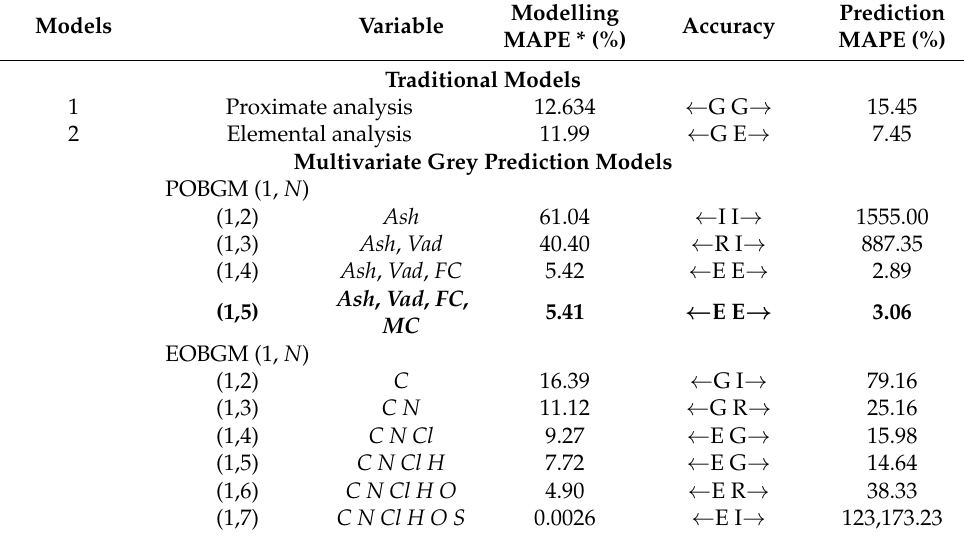
Table 4. Comparison of the selected